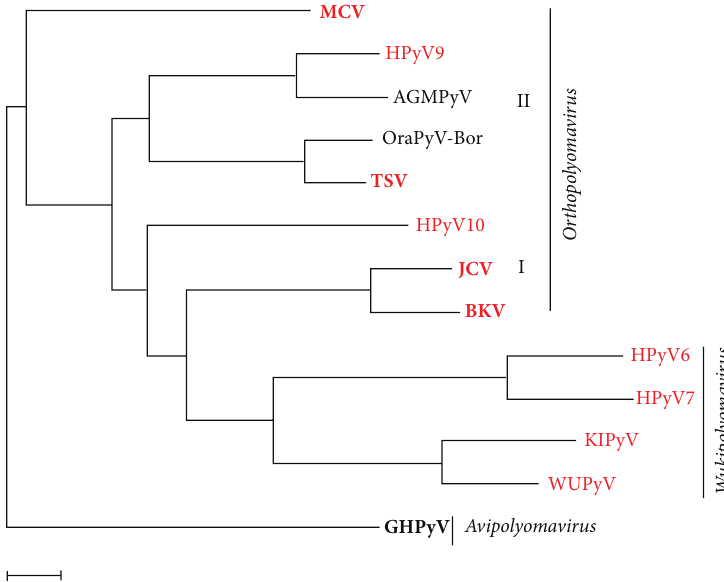
Figure 1: Phylogenetic relationships of the human polyomaviruses. Human polyomaviruses are presented in red with those associated with clinical disease in bold. The mammalian genera within the Polyomaviridae family: Orthopolyomavirus and Wukipolyomavirus and the single Avipolyomavirus genus member (employed as an outgroup) are indicated. Maximum likelihood phylogenetic analysis was performed on polyomaviral whole genome nucleotide sequences. Abbreviations and GenBank accession numbers employed as follows: AGMPyV, African green monkey polyomavirus (NC004763); BKV, BK polyomavirus (NC001538); goose haemorrhagic polyomavirus (GHPyV) genus (NC004800); HPyV6, human polyomavirus 6 (NC 004800); HPyV7, human polyomavirus 7 (HM011565); JCV, JC polyomavirus (NC001699); KIPyV, KI polyomavirus (NC 009238); MCV, The Merkel cell polyomavirus (HM011539); HPyV9, human polyomavirus 9 (HQ696595); MWHPyV, The Malawi polyomavirus (JX262162); TSV, trichodysplasia spinulosa-associated polyomavirus (GU989205); WUPyV, WU polyomavirus